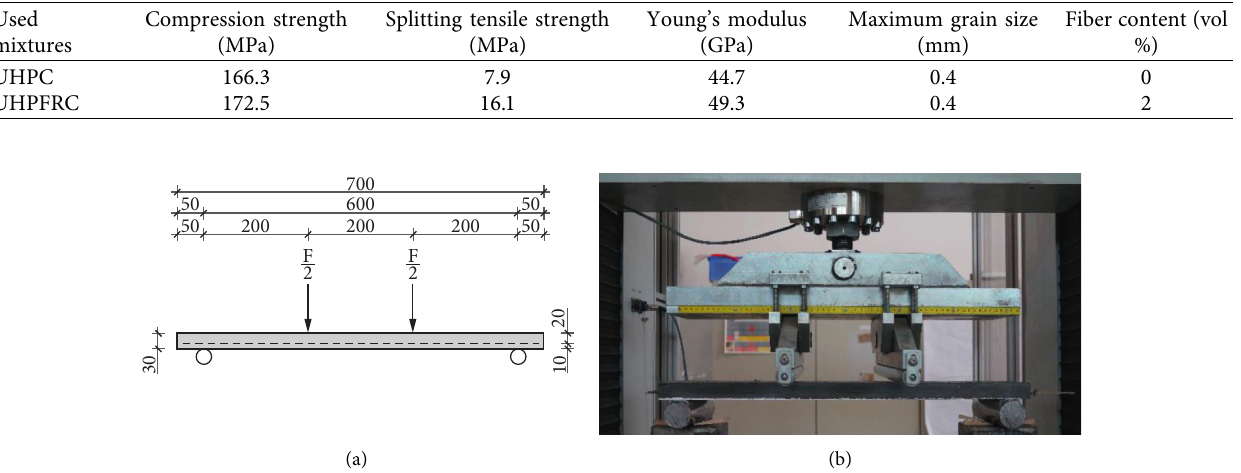
Table 4: Main properties of the used UHPC and UHPFRC mixtures 28 days after casting.